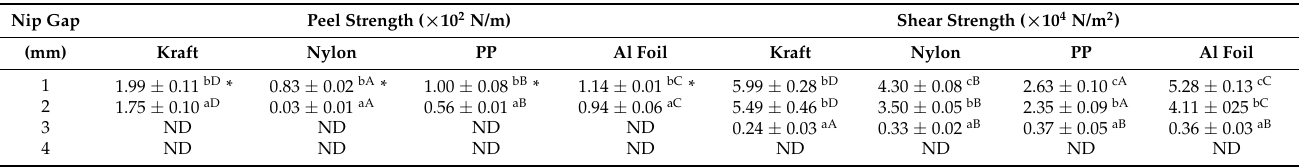
Figure 4. SEM micrographs of the substrate surfaces: ( a ) kraft paper; ( b ) nylon film; ( c ) PP film, and ( d ) Al foil. Table 2. Peel and shear strengths of NR-PSA/CO produced with 20 phr of XG + 0.06 phr of CO with a mastication time of 10 min for different nip gaps.